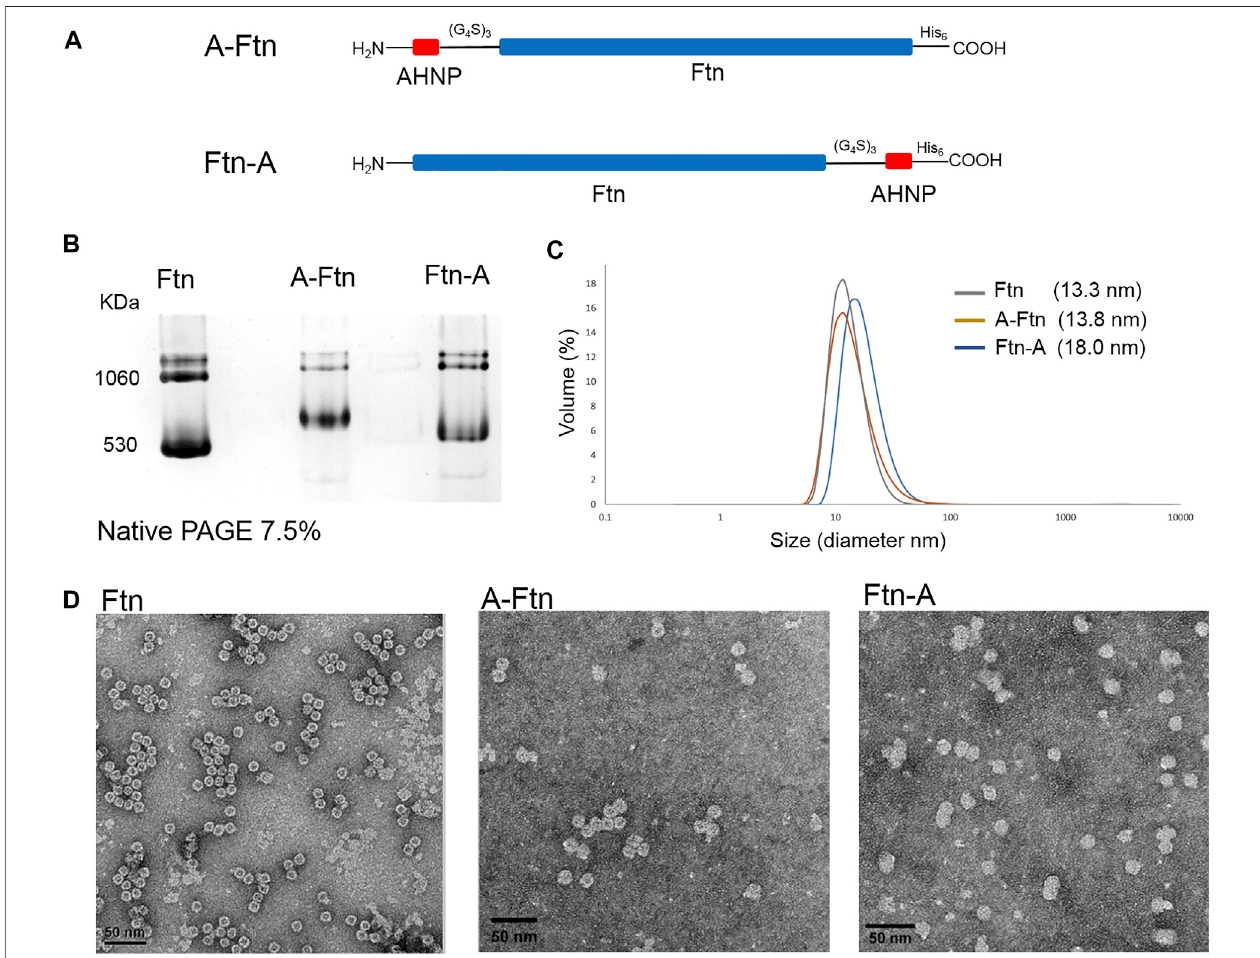
FIGURE5| StructuraleffectsfromthefusedAHNPpeptideonFtn. (A) IllustrationofA-FtnandFtn-Aproteinconstructs.AHNPistheanti-Her2/neupeptide.(G 4 S) 3 denotes a triple GGGGS peptide sequence. His 6 indicates C-terminal Histag. (B) Assembling analysis of Ftn, A-Ftn, and Ftn-A proteins. Proteins are analyzed by 7.5% nativePAGEandvisualizedbyInstantBluestaining. (C) DLSanalysisofFtnandAHNPfusedFtn.Theproteinconcentrationissettobe0.5 mg/mlin50 mMTris – HCland 100 mM NaCl at pH 7.4. (D) TEMimagesofFtn, A-Ftn, and Ftn-A. Scale bar represents 50 nm.The protein concentrationis set tobe 50 μ g/ml in 50 mM Tris – HCl at pH